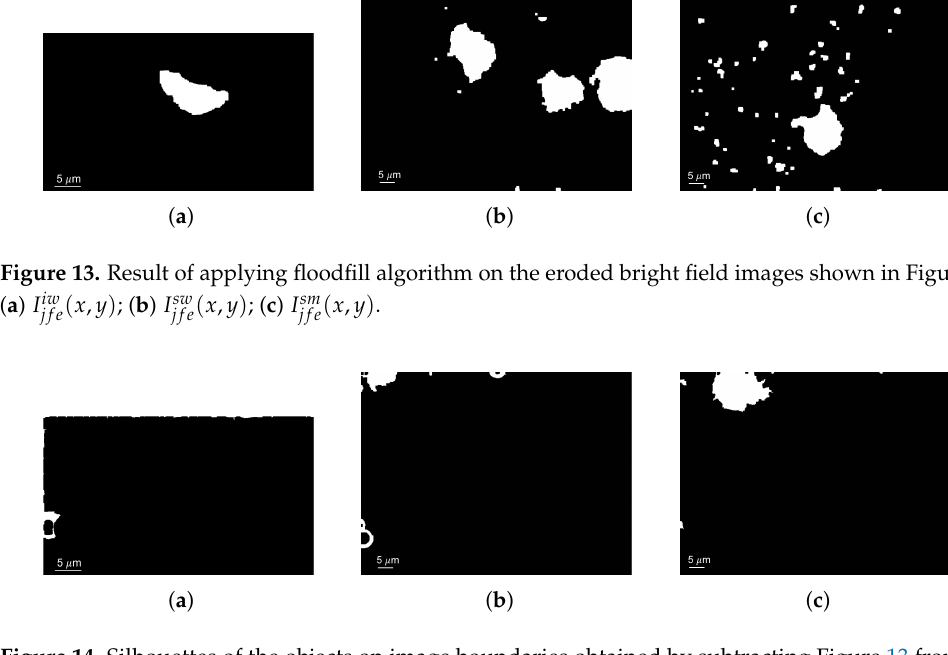
( x , y ) ; ( b ) I sw ( x , y ) ; ( c ) I sm ( x , y ) js js js